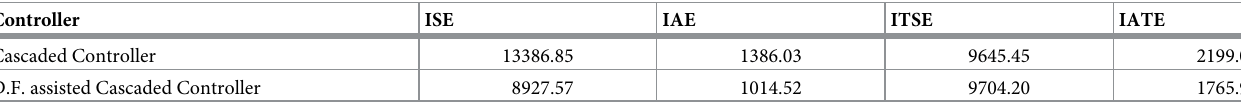
Table 6. Objective function for pressure control system.